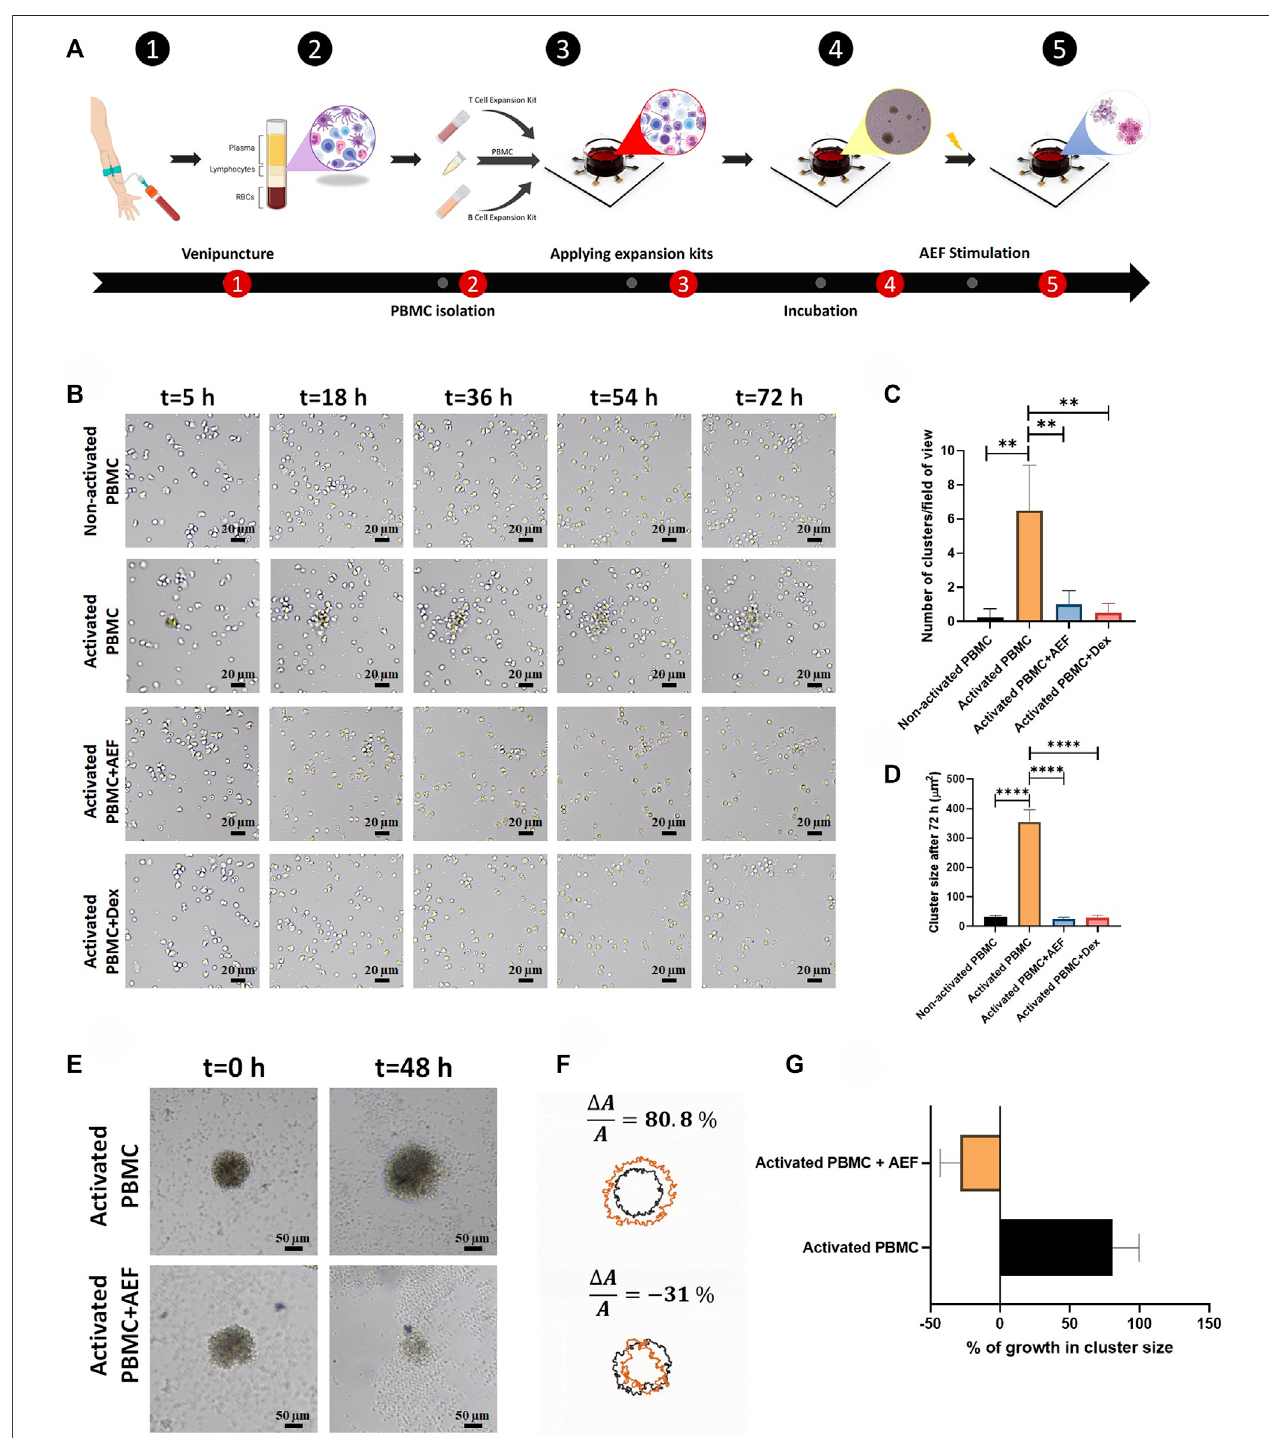
FIGURE 2 | (A) The whole blood was obtained through the venipuncture technique. The PBMCs were isolated from the whole blood using density gradient centrifugation. Isolated PBMCs were cultured inside the cell culture medium and their lymphocytes were activated by the use of expansion kits. The whole set-up was incubated for 5 days to ensure lymphocytes activation. The system was stimulated using the alternating electric fi eld for 48 h which caused apoptosis in clusters of activated lymphocytes during cell division. (B) Lymphocyte cluster formation inside the immune cell activation medium was evaluated via time-lapse imaging. No sign of cluster formation was observed in non-activated PBMCs, while clustering was con fi rmed in activated PBMCs. Alternating electric fi eld stimulation and the use of dexamethasone (4 mg/ml) similarly inhibited cluster formation in activated PBMCs. (C, D) The highest number of clusters were observed in activated PBMCs. These